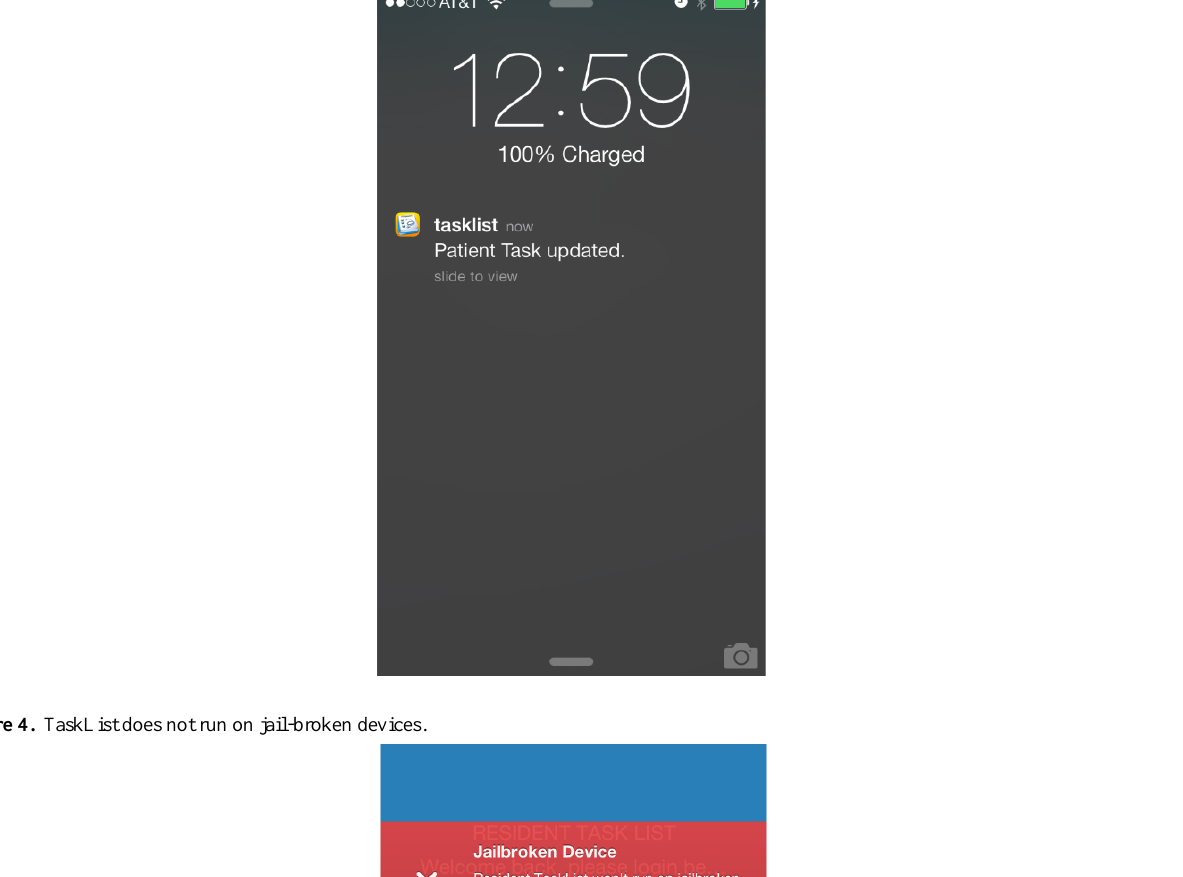
Figure 3. Tasklist limited notifications.